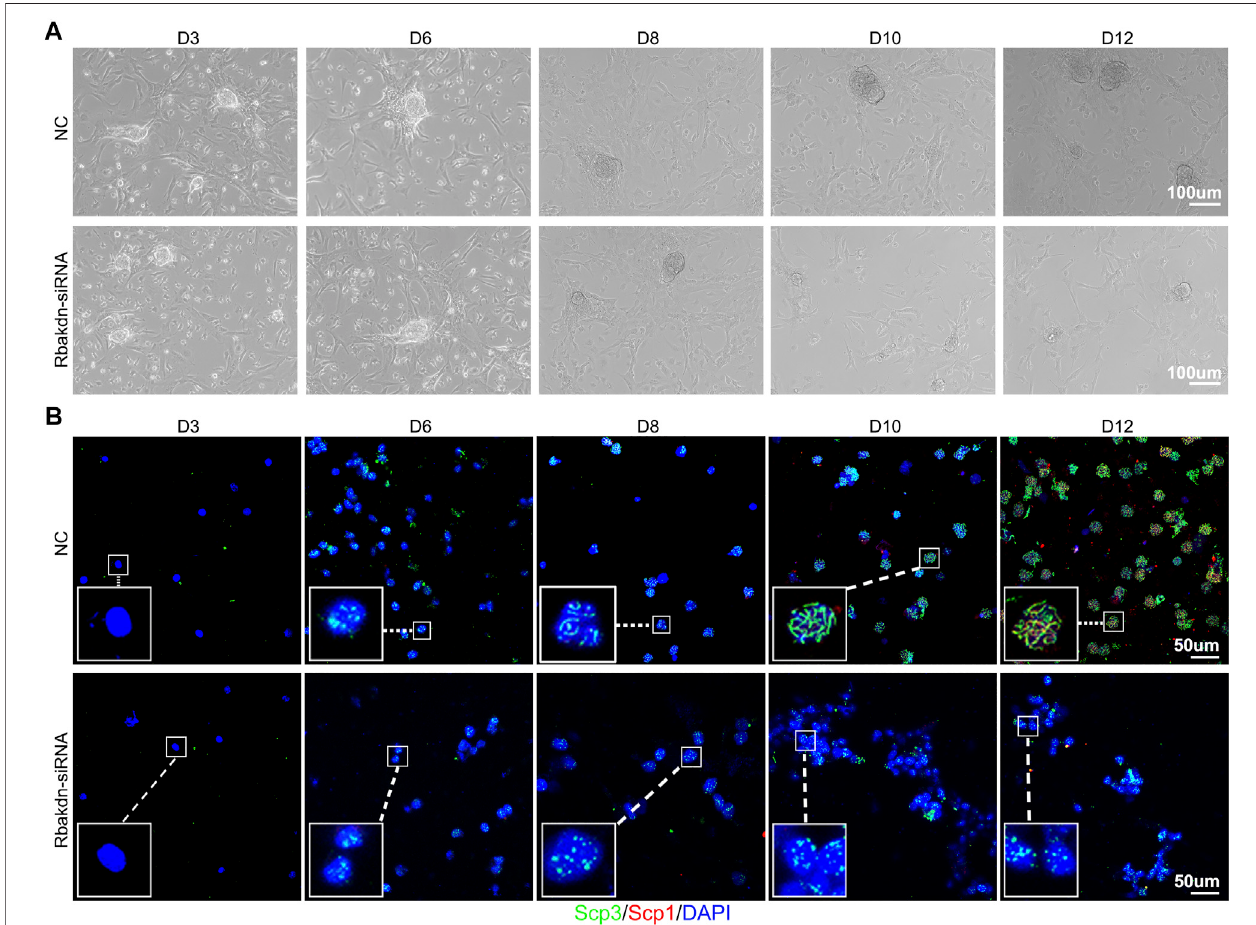
FIGURE 2 | Knockdown of Rbakdn inhibits the process of meiosis induced in vitro . (A) The process of spermatogonial proliferation to form clones after treatment with Rbakdn-siRNA. Sertoli cells adhered to form a feeder layer, and spermatogonia migrated around the support cells and gradually proliferated and differentiated to formclones. (B) Immuno fl uorescencecostainingafterchromosomalspreadingofspermatogeniccellstreatedwithRbakdn-siRNA atdifferentstagesofmeiosisinduced in vitro . Blue: cell nucleus; red: SCP1; green: SCP3. Scale bar: 50 µm.